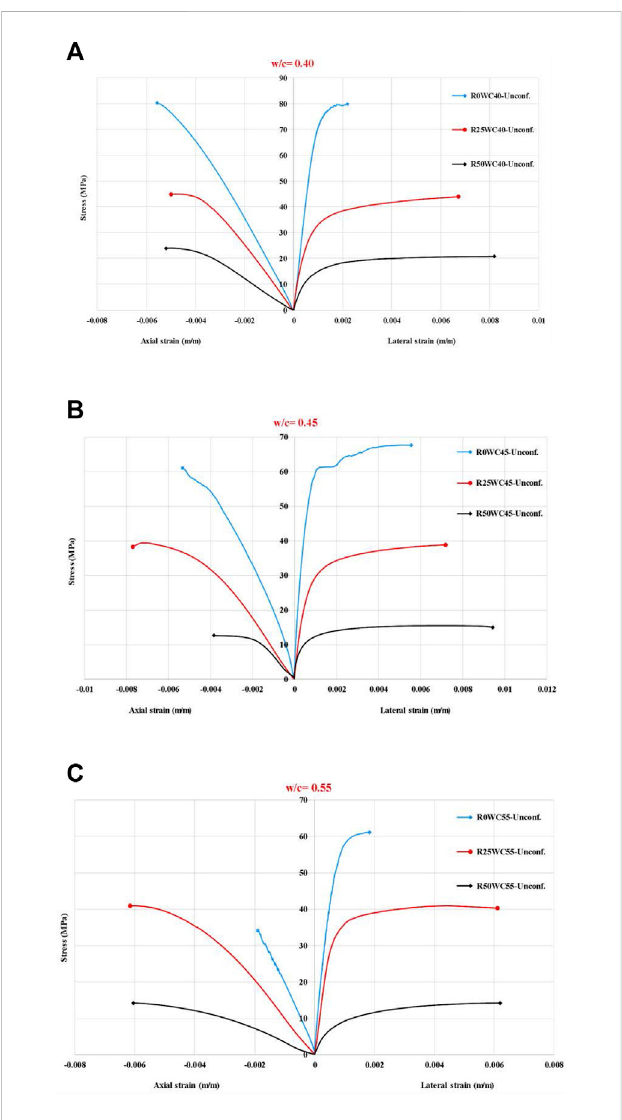
Stress-strain curve for cylinders with different ratio of PET and: (A) .40 w/c; (B) .45 w/c; and (C) .55